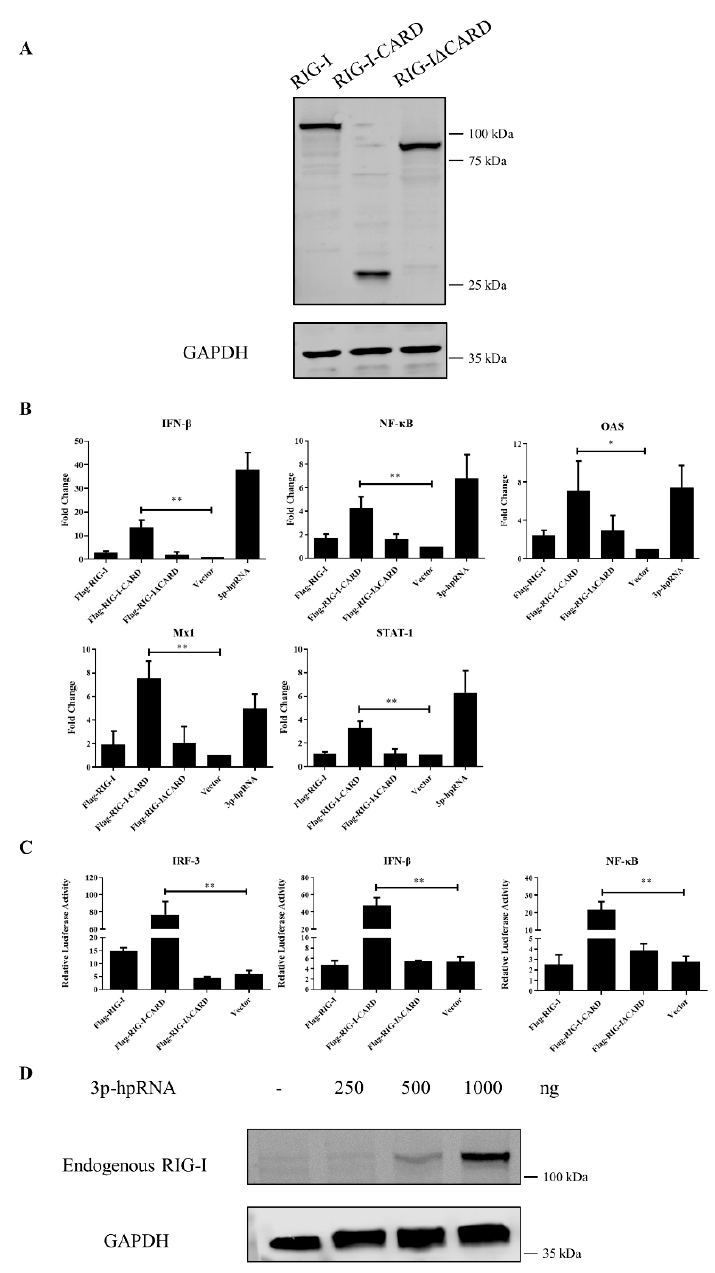
Figure 3. Gene expression in MDCK cells overexpressing full-length or partial forms of RIG-I or RIG-I agonist. ( A ) MDCK cells transfected with plasmids Flag–RIG-I, Flag–RIG-I-CARD or Flag–RIG-I Δ CARD, respectively. The whole cells protein was obtained after 24 h. ( B ) Relative mRNA expression levels of NF- κ B, IFN- β , Mx1, OAS, and STAT-1 were evaluated by qRT-PCR 24 h after transfection of Flag–RIG-I, Flag–RIG-I-CARD, Flag–RIG-I ∆ CARD, 3p-hpRNA, or empty vector. ( C ) Effect of overexpression of the various constructs on IRF-3, NF- κ B, and IFN- β promoter activity as determined with the luciferase assays 24 h after transfection. Samples were analyzed in triplicate and three independent experiments were performed. * p < 0.05, ** p < 0.01 vs. empty vector control group. Error bars indicate standard deviation. ( D ) MDCK cells were transfected with indicated concentrations of RIG-I agonist and the whole cells protein was obtained after 24 h; the expression level of endogenous RIG-I was determined by western blotting with GAPDH used as a loading